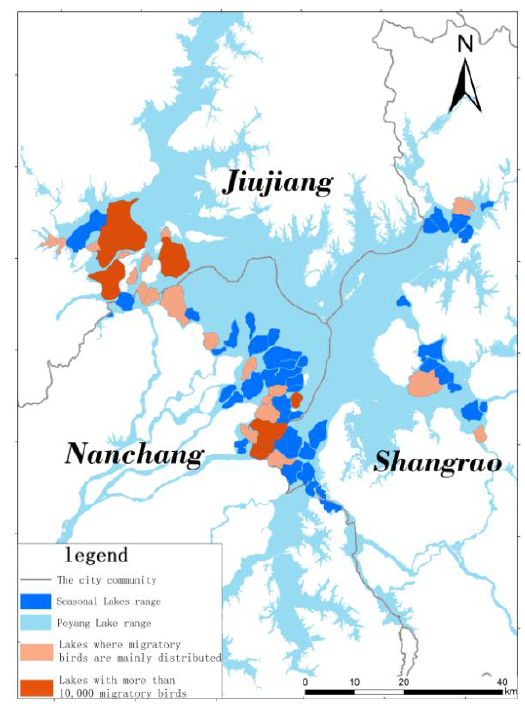
Figure 10. The distribution of migratory birds in seasonal lakes.